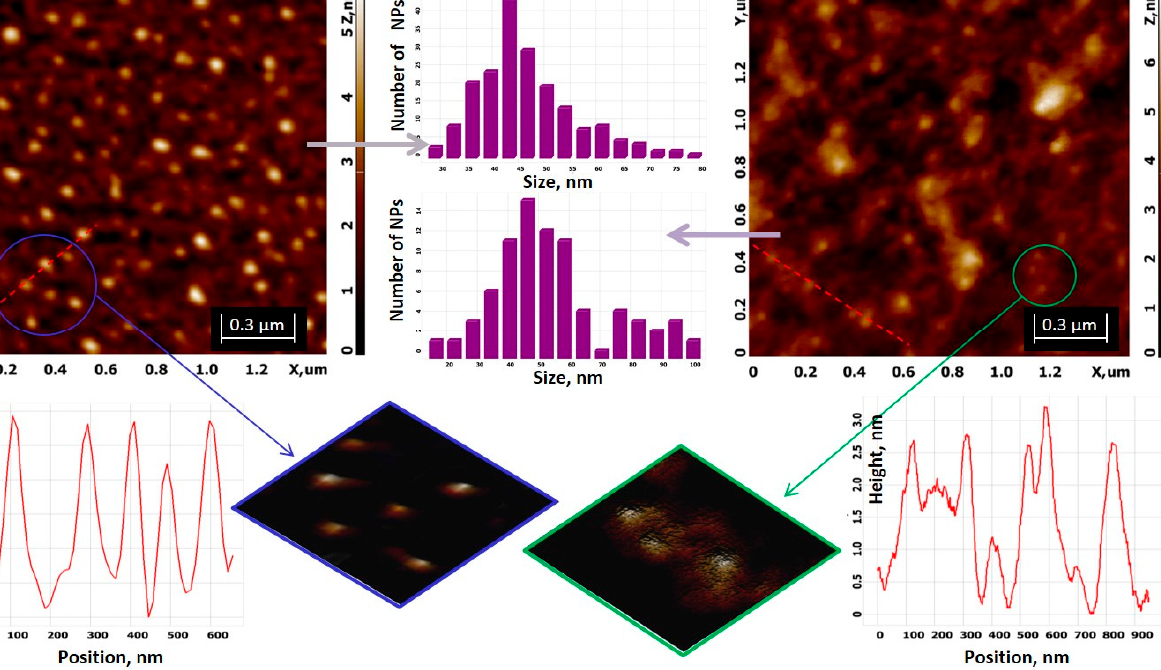
Figure 5. Topologies of Ag/AgClNPs (P3, left ) and Ag/AgClNPs–CTS Biohybrid I (P4, right ) with size distributions (in the middle ) for both systems, obtained using Image Analysis software (version 3.5) (https://nexus.ntmdt.ru/dl_3687; accessed on 4 March 2020). Bottom figures (from left to right): height analysis in the selected direction (red dashed line) and magnified 3D visualization of the selected blue area for the P3 system, cropped 3D image of the selected green area, and height analysis in the selected direction (red dashed line) for the P4 system.